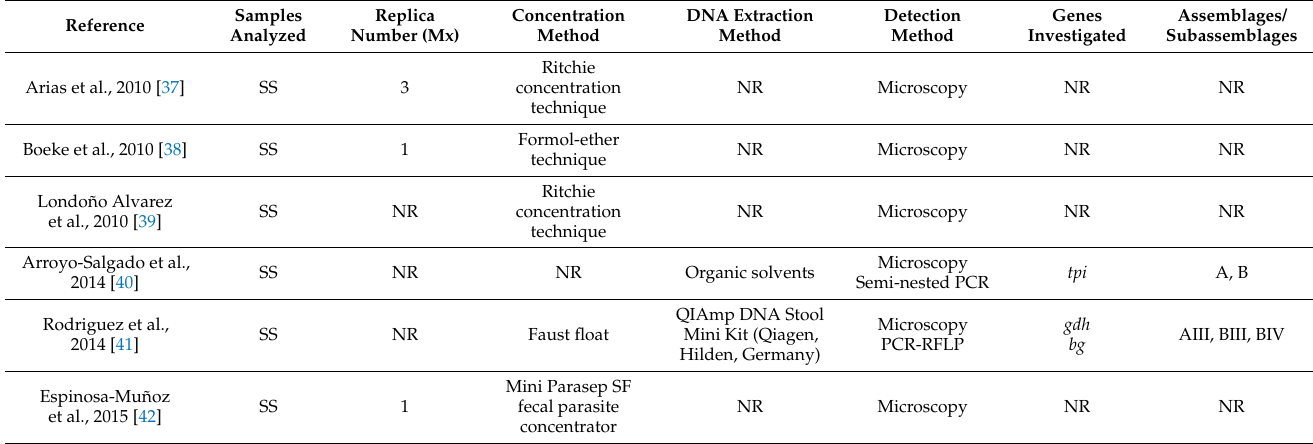
Table 2. Characteristics of molecular test used in the selected